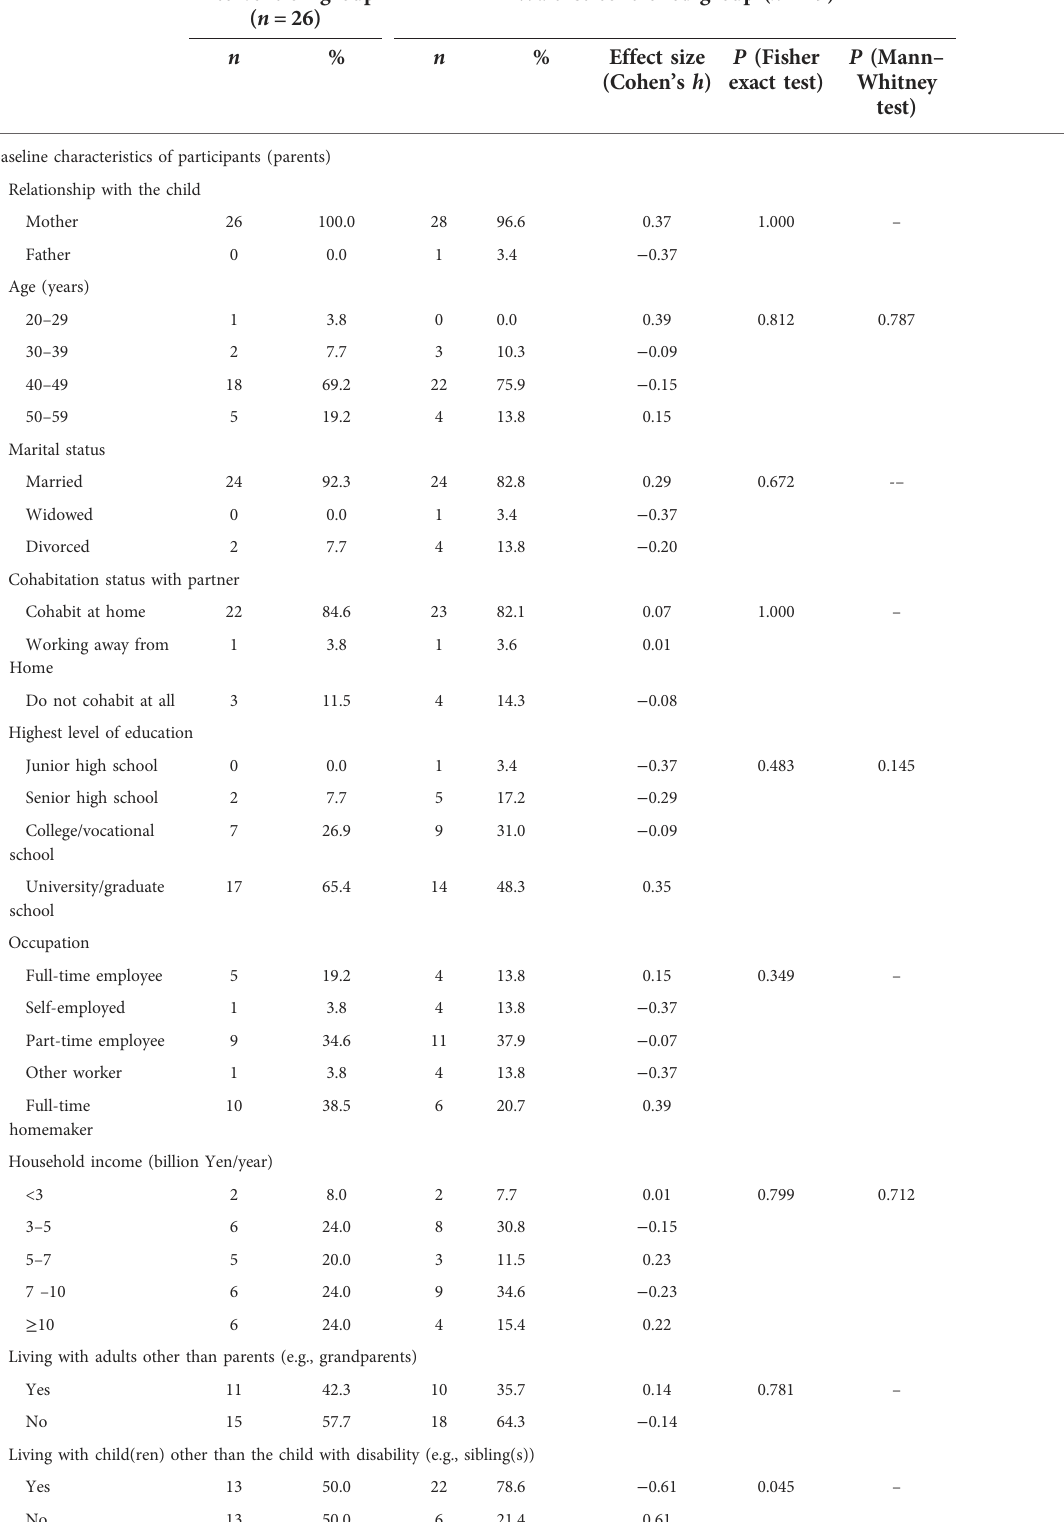
TABLE 2 Participant